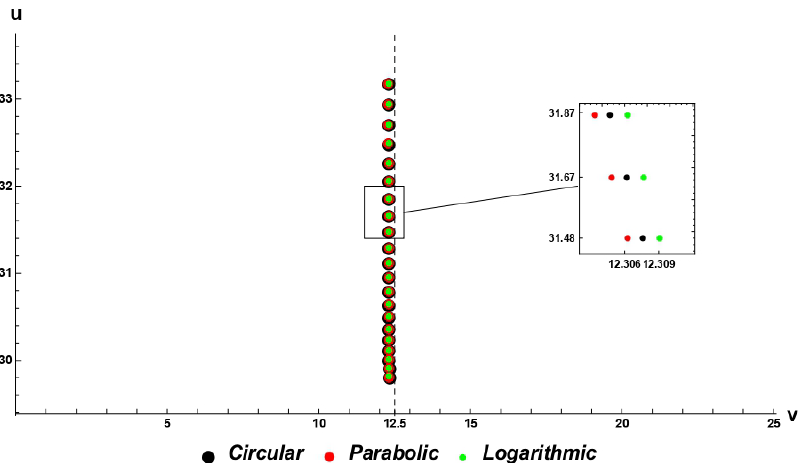
Figure 10. Path of contact of longitude circular, parabolic, and logarithmic crowned spur gear with 0.4° (7.0 mrad) of in-plan angular misalignment. The dashed line is the center of the tooth surface along gear width.